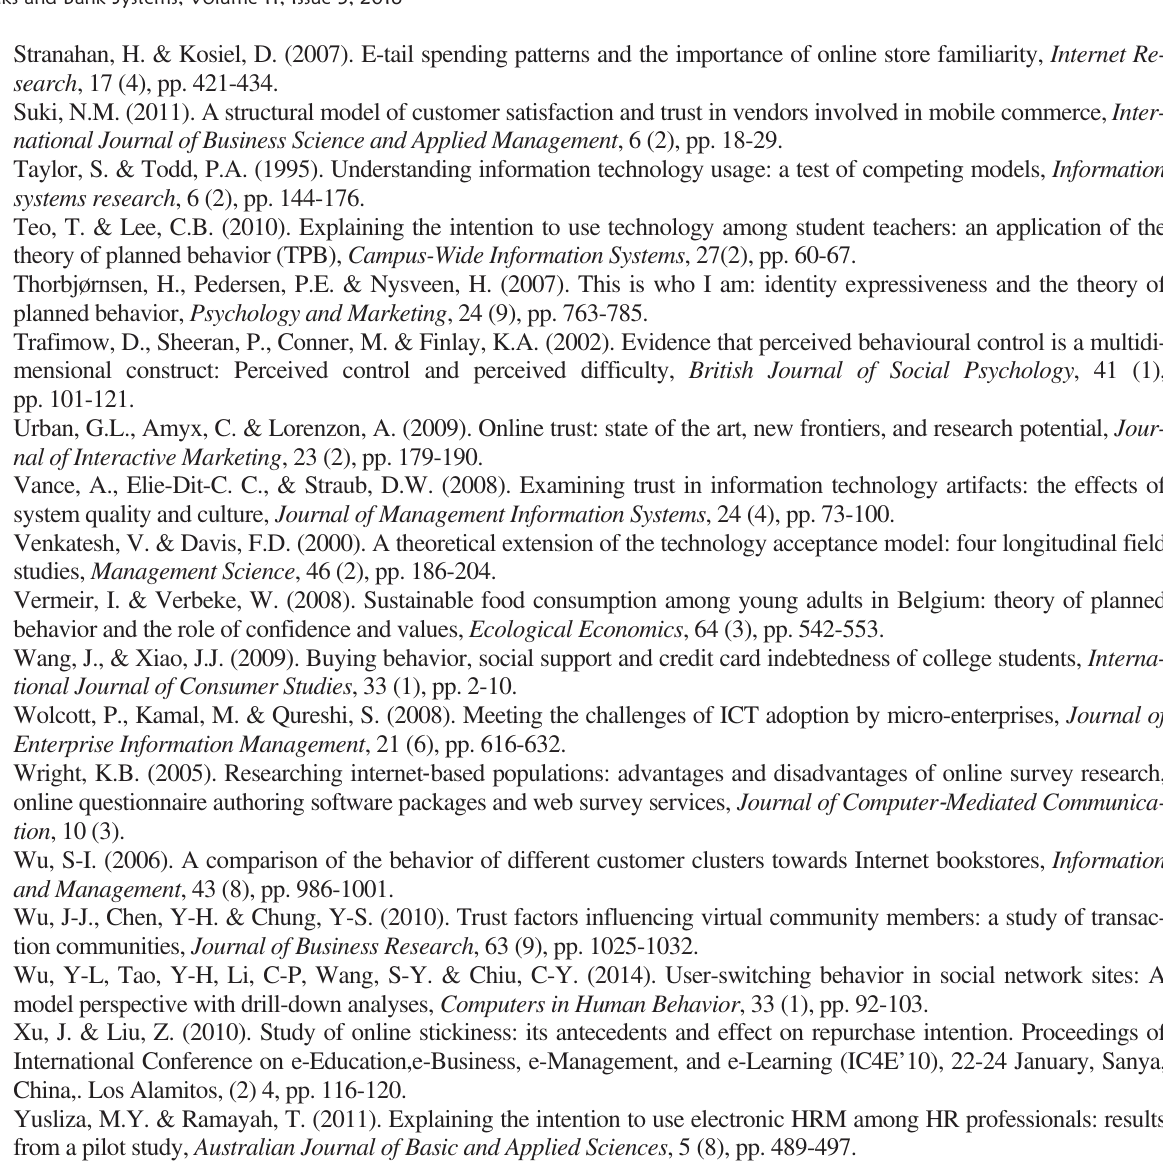
Table 1. Operationalization of psychosocial factors influencing OSN continuance intention Factor Measurement Adopted source Perceived behavioral control